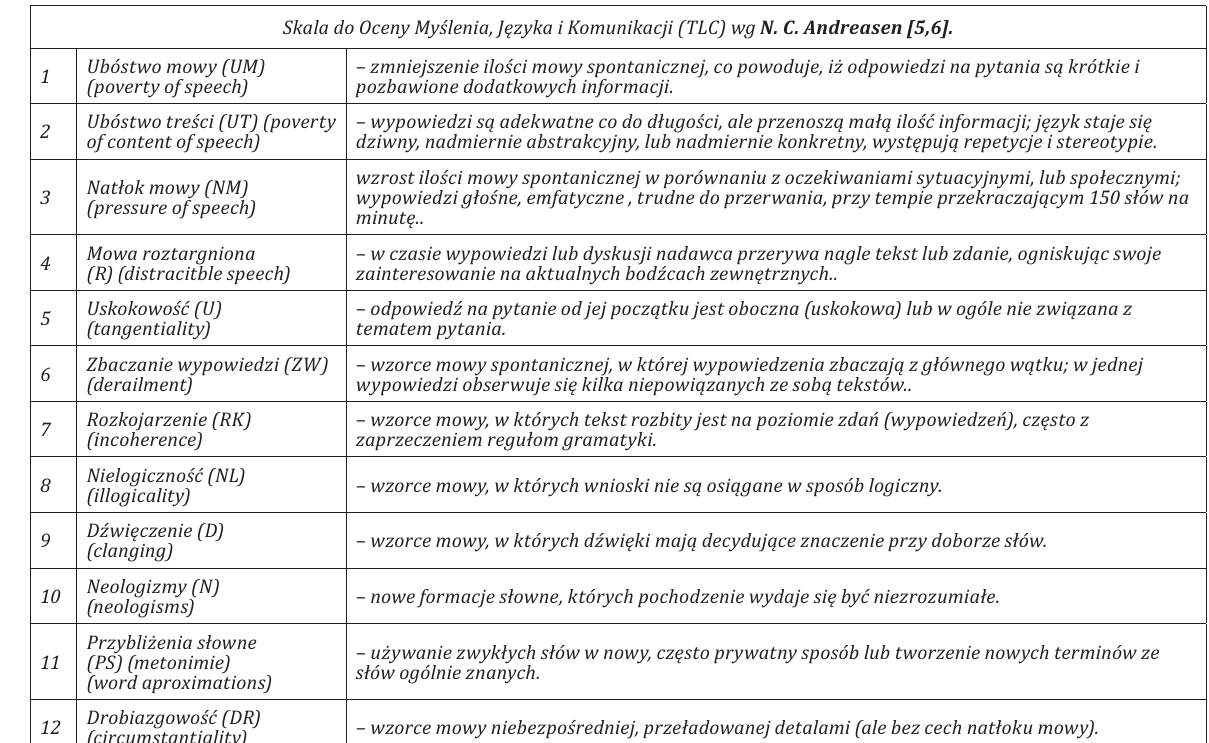
Tabela 1. Kategorie oceny wypowiedzi w Skali